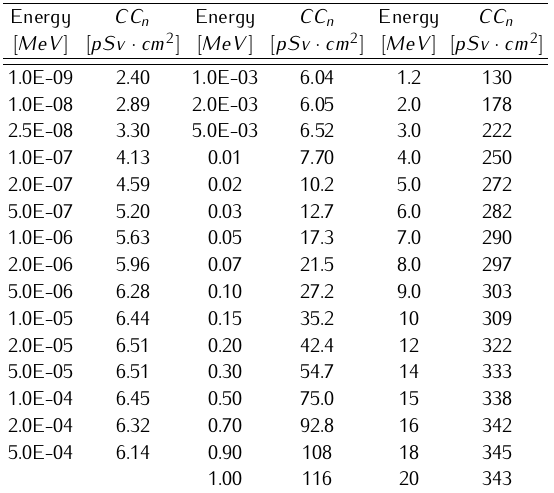
n as the effective dose per